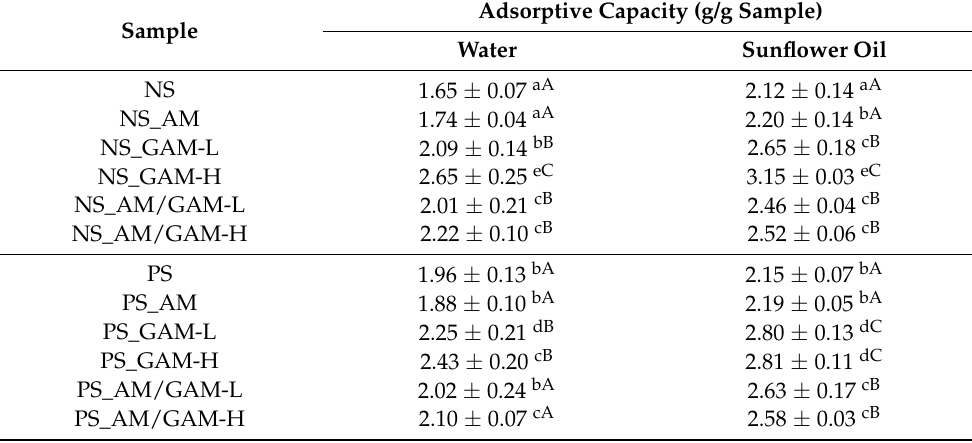
Table 3. Adsorptive capacity of NS and PS